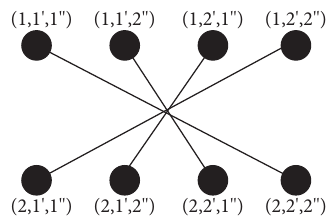
Figure 4: NEPS P